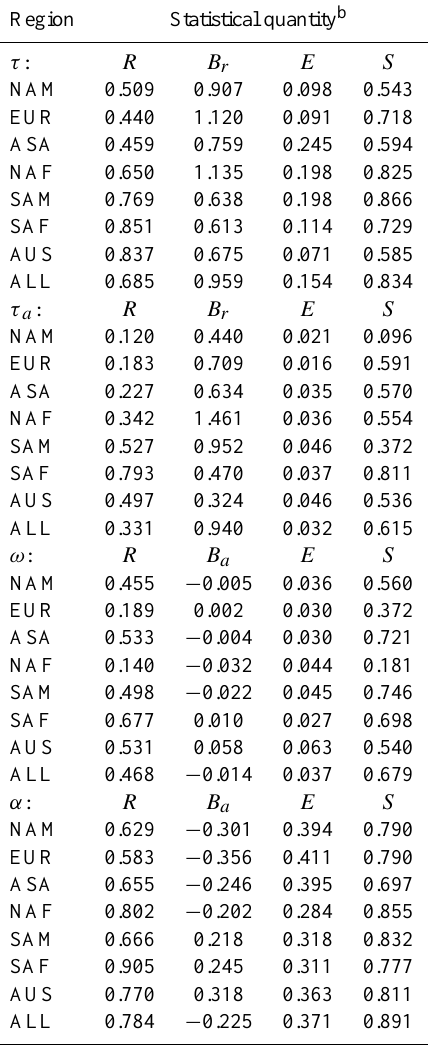
Statistics of AERONET-GOCART comparisons